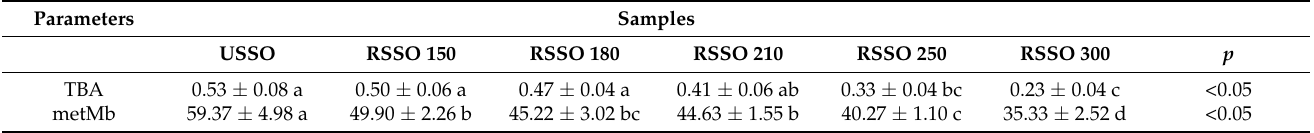
Table 7. Effects of addition of raw and roasted sesame seed oils at different temperatures on TBA (thiobarbituric acid) and metmyoglobin (metMb) reducing activity value in meatballs after 10 days cold